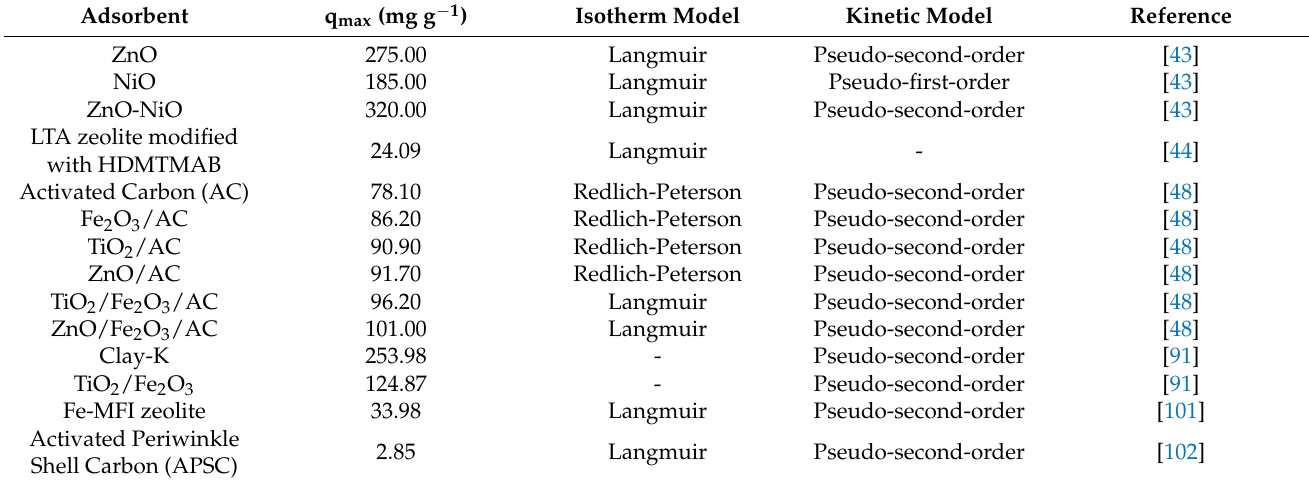
Table 5. Comparison of adsorption capacity (mg g − 1 ) of various materials for cyanide